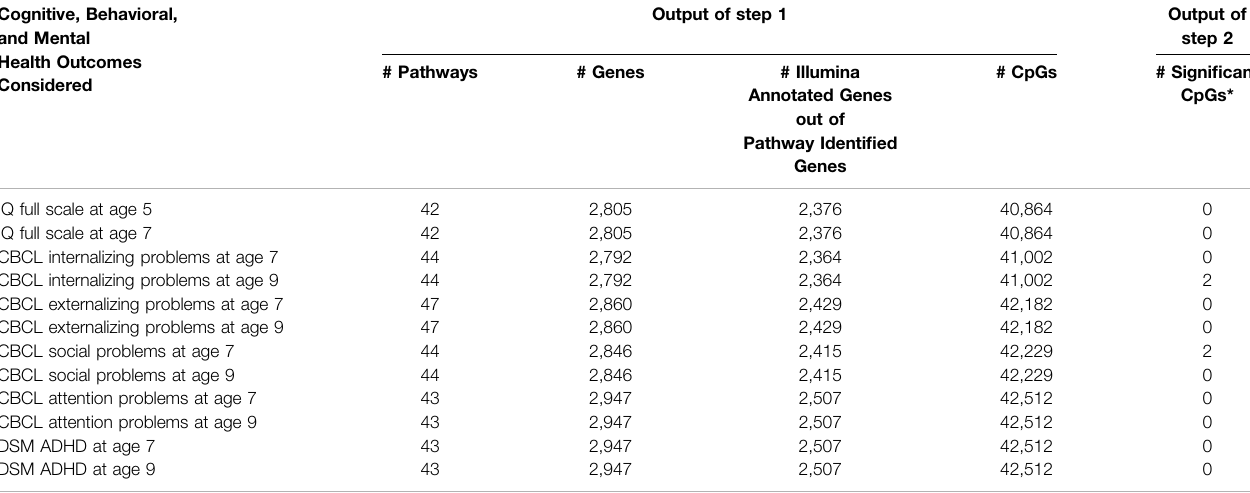
TABLE 2 | Numbers of selected pathways/genes/CpGs based on keywords and numbers of CpGs that are signi fi cantly associated with outcomes (Output of Step 1 and Step 2). Cognitive, Behavioral, and Mental Health Outcomes